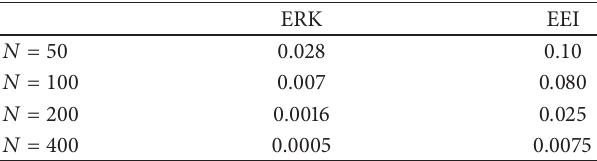
Table 1: The stability comparison of ERK method and EEI method.